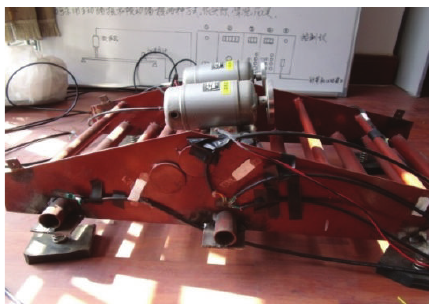
Figure 4: The strain test photo for the model screen.